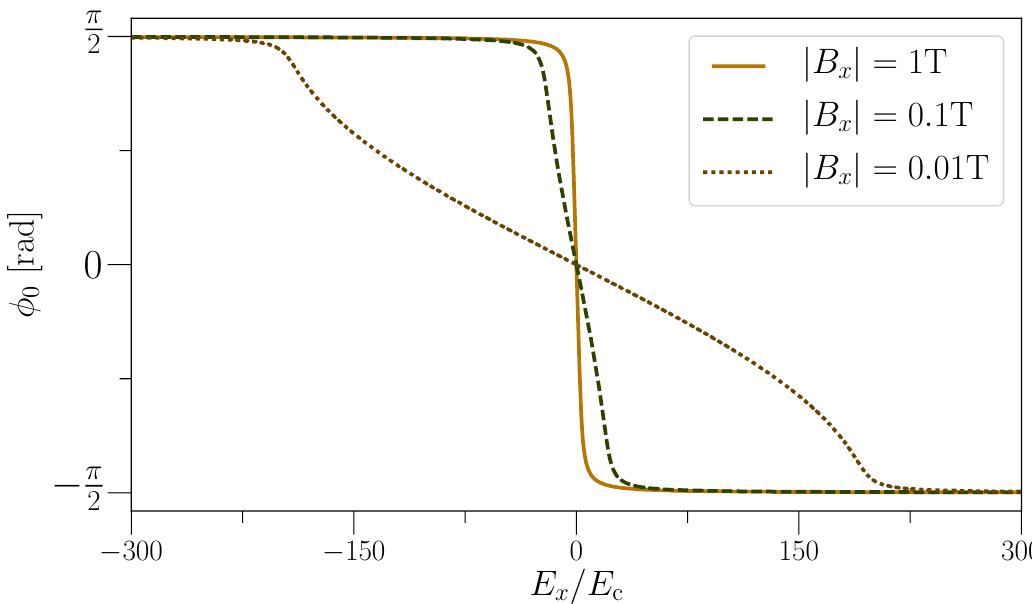
Figure 2: The internal angle, φ ferent values of B solid line corresponds to | B and the dotted .. line to | B